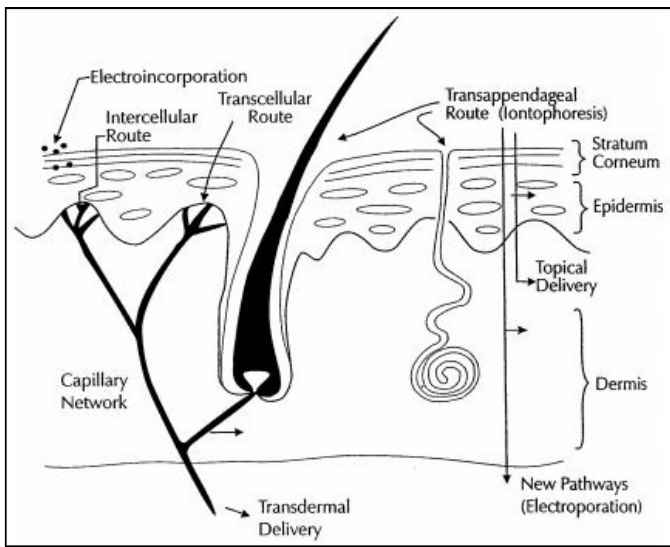
Figure 1. Schematic illustration showing the pathways of topical and transdermal delivery, including electrically assisted delivery by iontophoresis, electroporation, and electroincorporation [7].